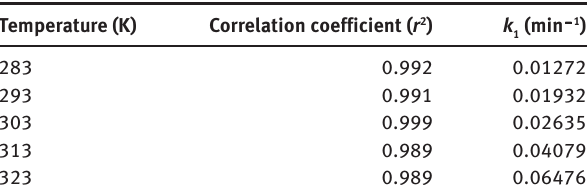
Table 3: First-order kinetic parameters of the catalytic oxidation of DBT at different